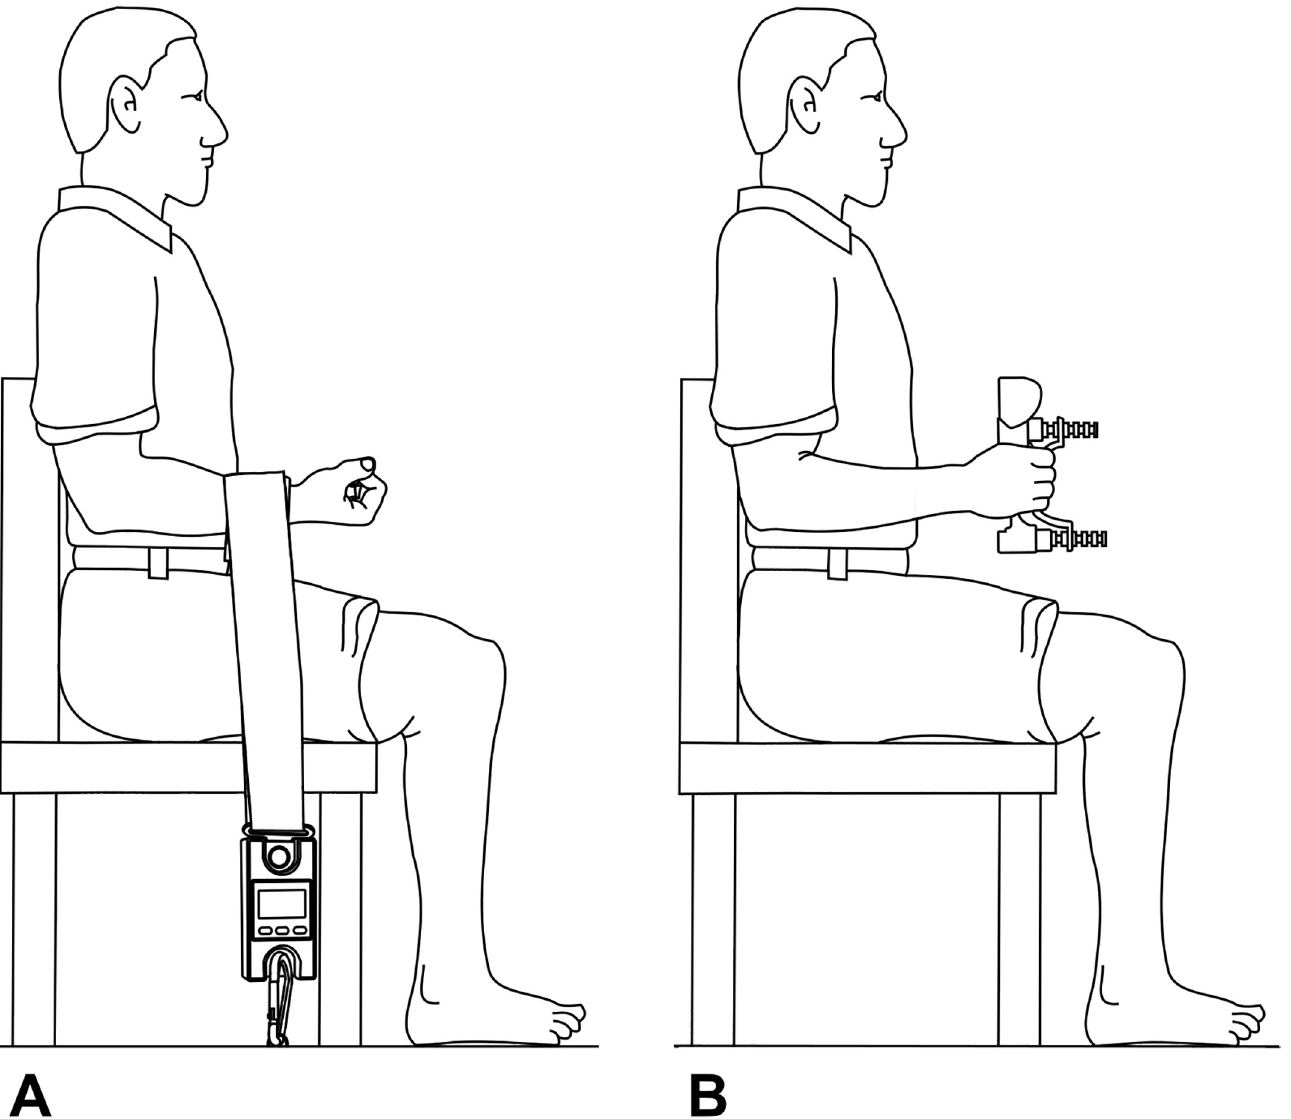
Fig 2. Tests of muscle strength. (A) Isometric elbow flexion strength. The participant pulled their arm against the Velcro strap by attempting to move their hand towards their shoulder as forcefully as they could for 2–3 seconds. (B) Handgrip strength. The participant squeezed the handheld dynamometer as forcefully as they could for 2–3